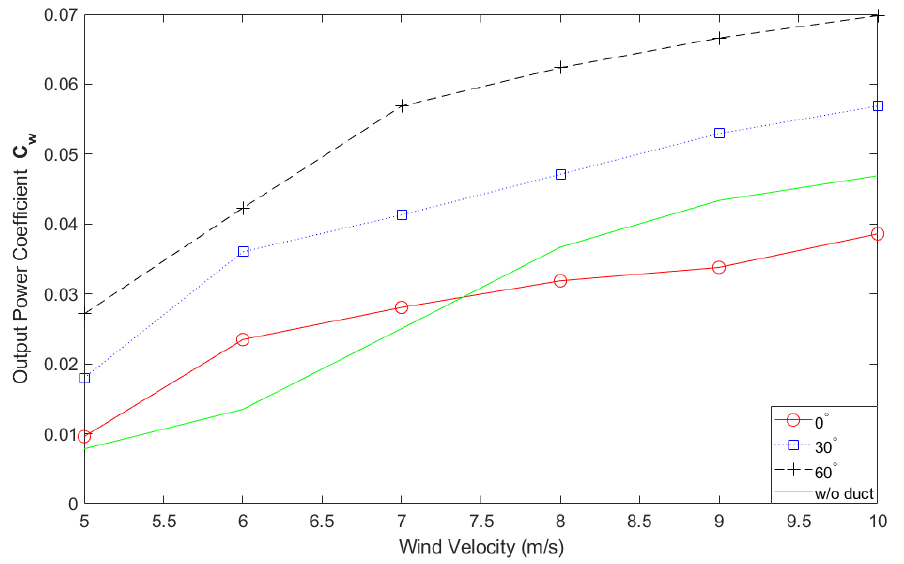
Figure 11. Comparison of output power coefficient.